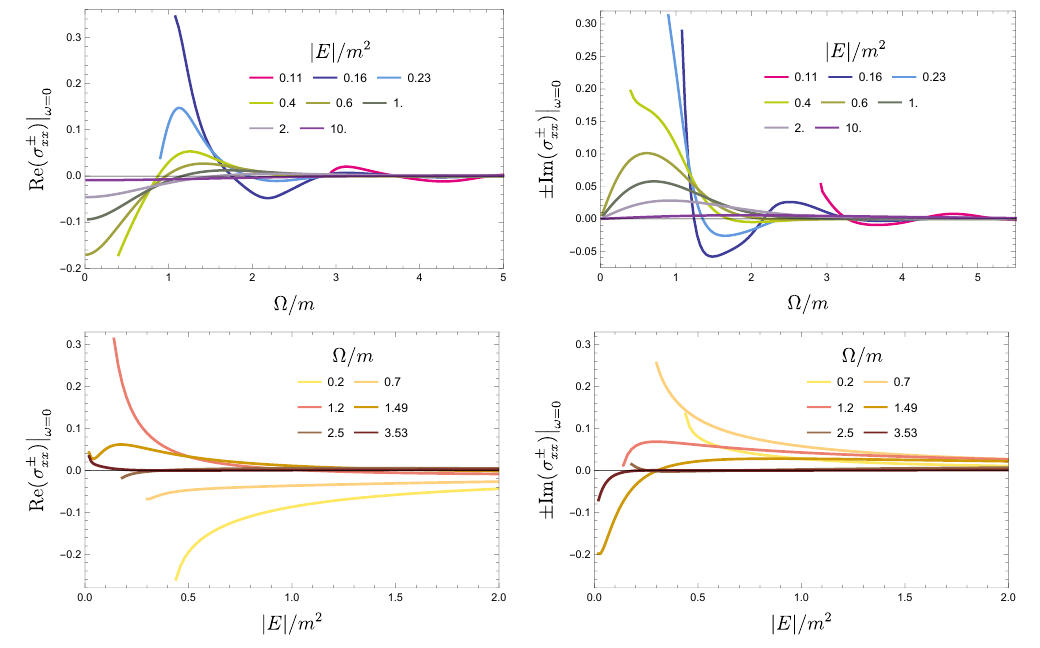
Figure 19 . DC conductivities (cid:27) (cid:6)